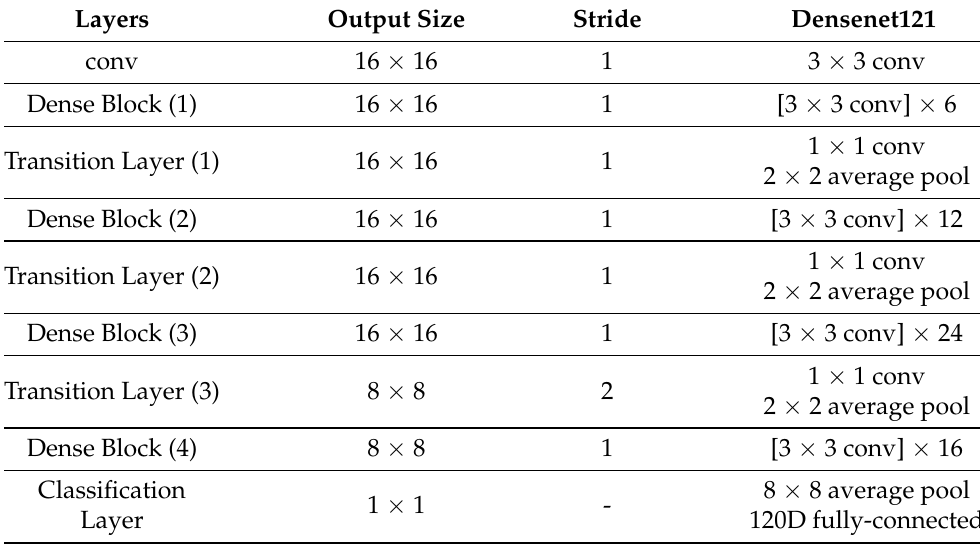
Table 3. DenseNet121 architectures for